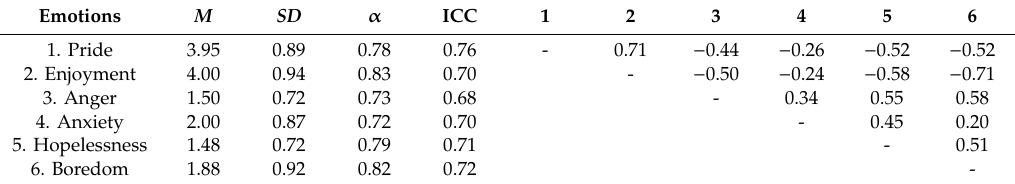
Table 4. Descriptive statistics, internal consistency, temporal stability and convergent validity.